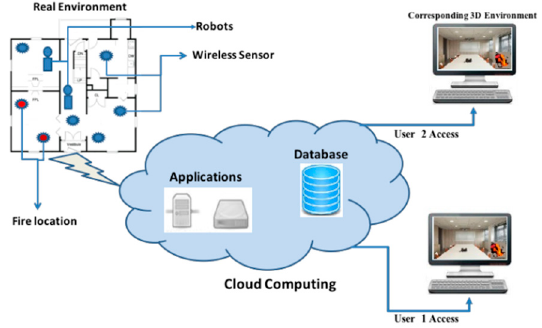
Figure 2. The overall system architecture.